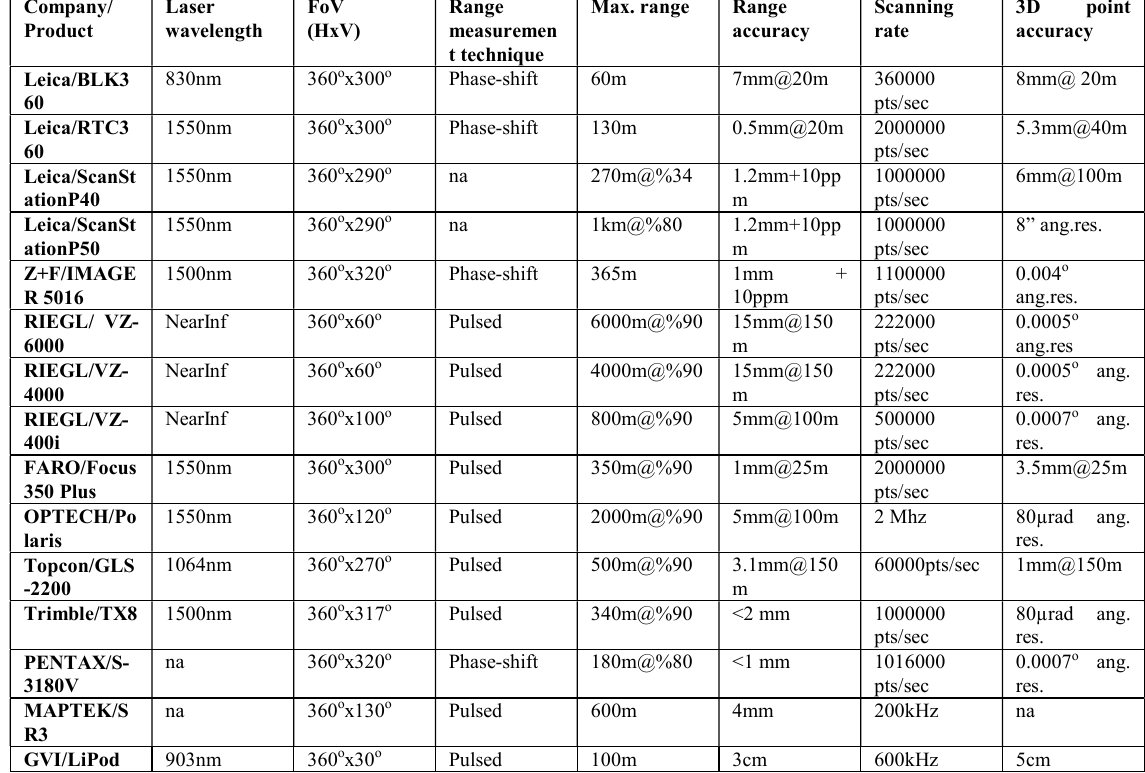
Table 1. Technical specifications of mechanical laser scanners.